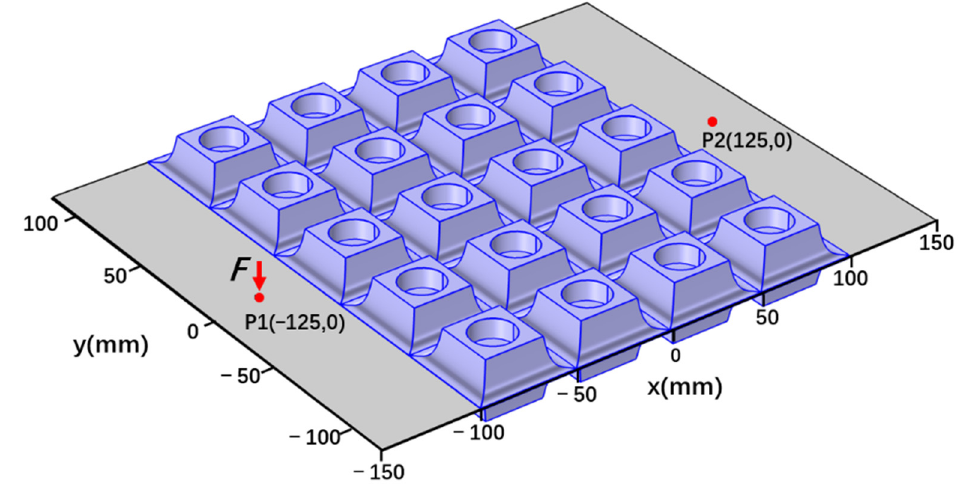
Figure 6. Vibration transfer model.